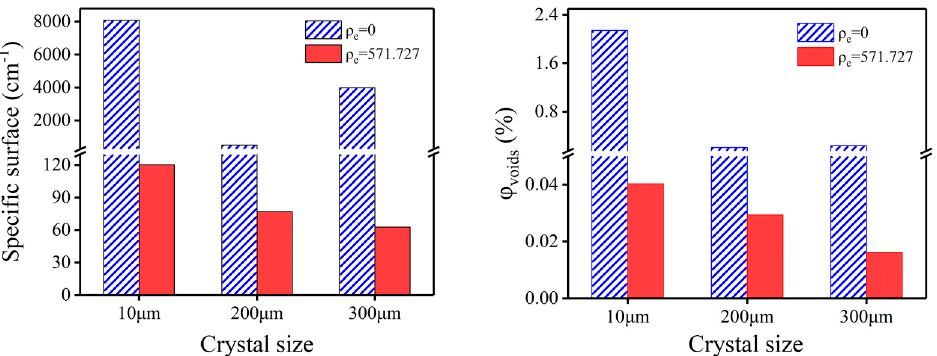
Figure 7. Specific surface (left) and volume fraction (right) of voids in air and perfluoropolyether matching solution of CL-20 crystals with di ff erent particle sizes. Table 3. Parameter calculation results of CL-20 crystal with different particle size under different conditions.